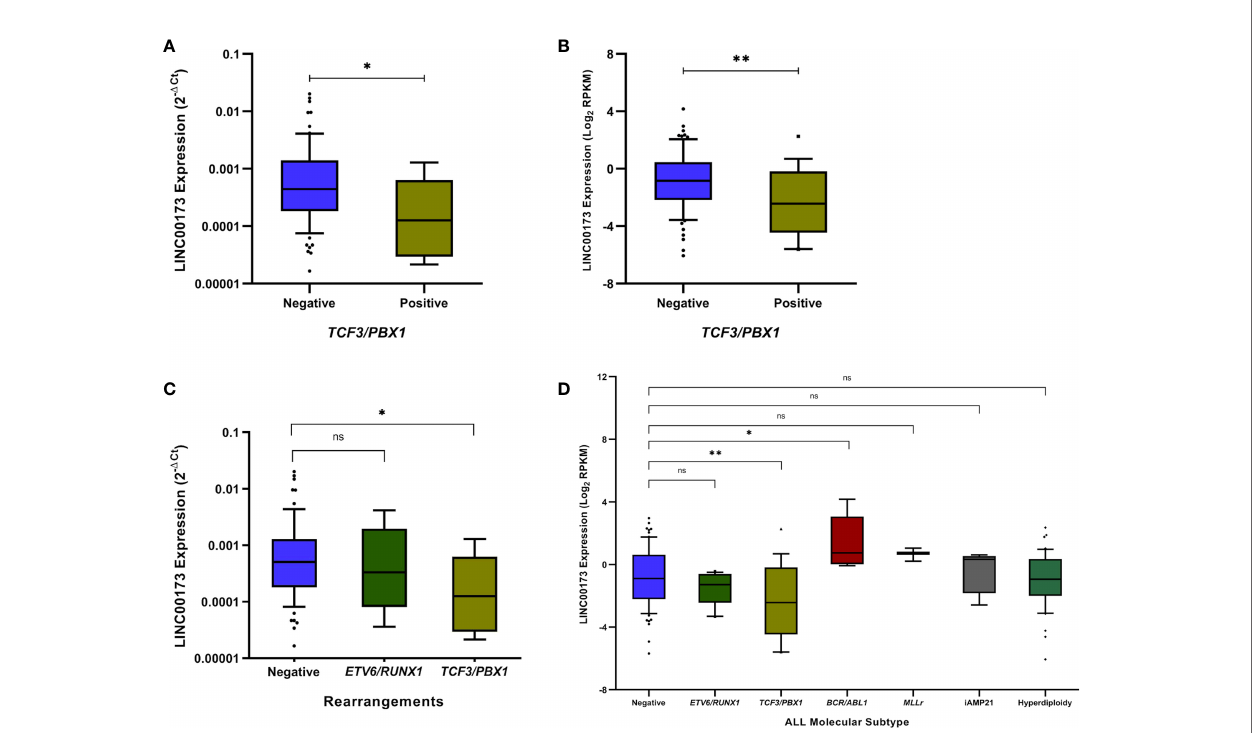
FIGURE 2 | LINC00173 expression analyses across molecular subtypes of B-cell precursor acute lymphoblastic leukemia (BCP-ALL). (A) LINC00173 is underexpressed in BCP-ALL cases positive to TCF3/PBX 1 fusion genes in the Mexican cohort and (B) TARGET cohort. (C) The TCF3/PBX 1 molecular subtype displays the lowest expression levels of LINC00173 in the Mexican and (D) TARGET cohorts, and the BCR/ABL subtype shows the highest expression levels of this lncRNA.* p < 0.05, ** p < 0.01, ns, non signi fi